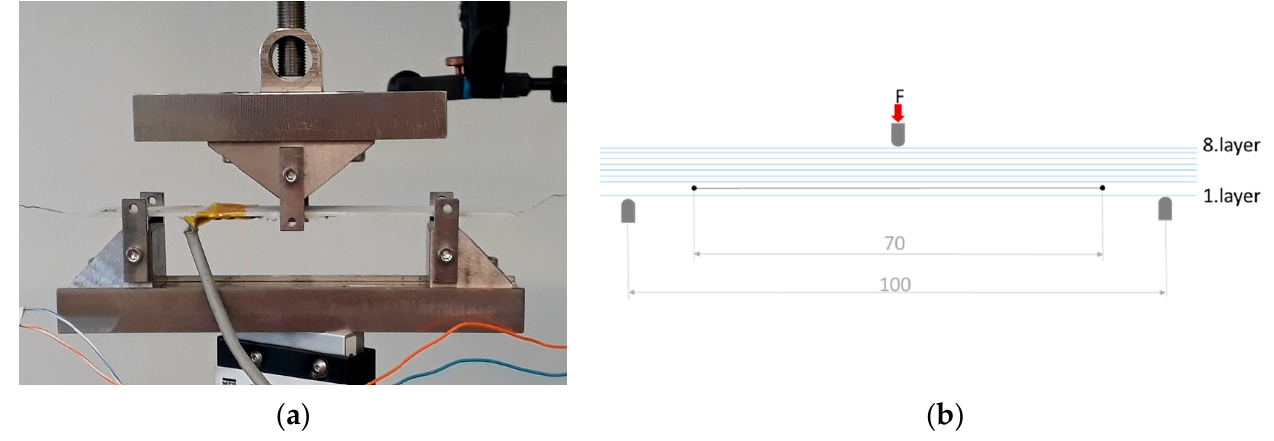
Figure 2. Configuration of the 3-point-bending test: ( a ) specimen during cyclic flexural loading; ( b ) configuration of the composite lay-up during cyclic flexural loading.